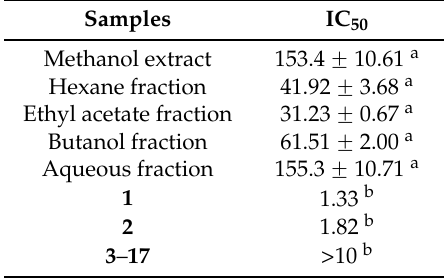
Table 1. Cytotoxicity of the extract, fractions, and compounds isolated from J. sinensis.